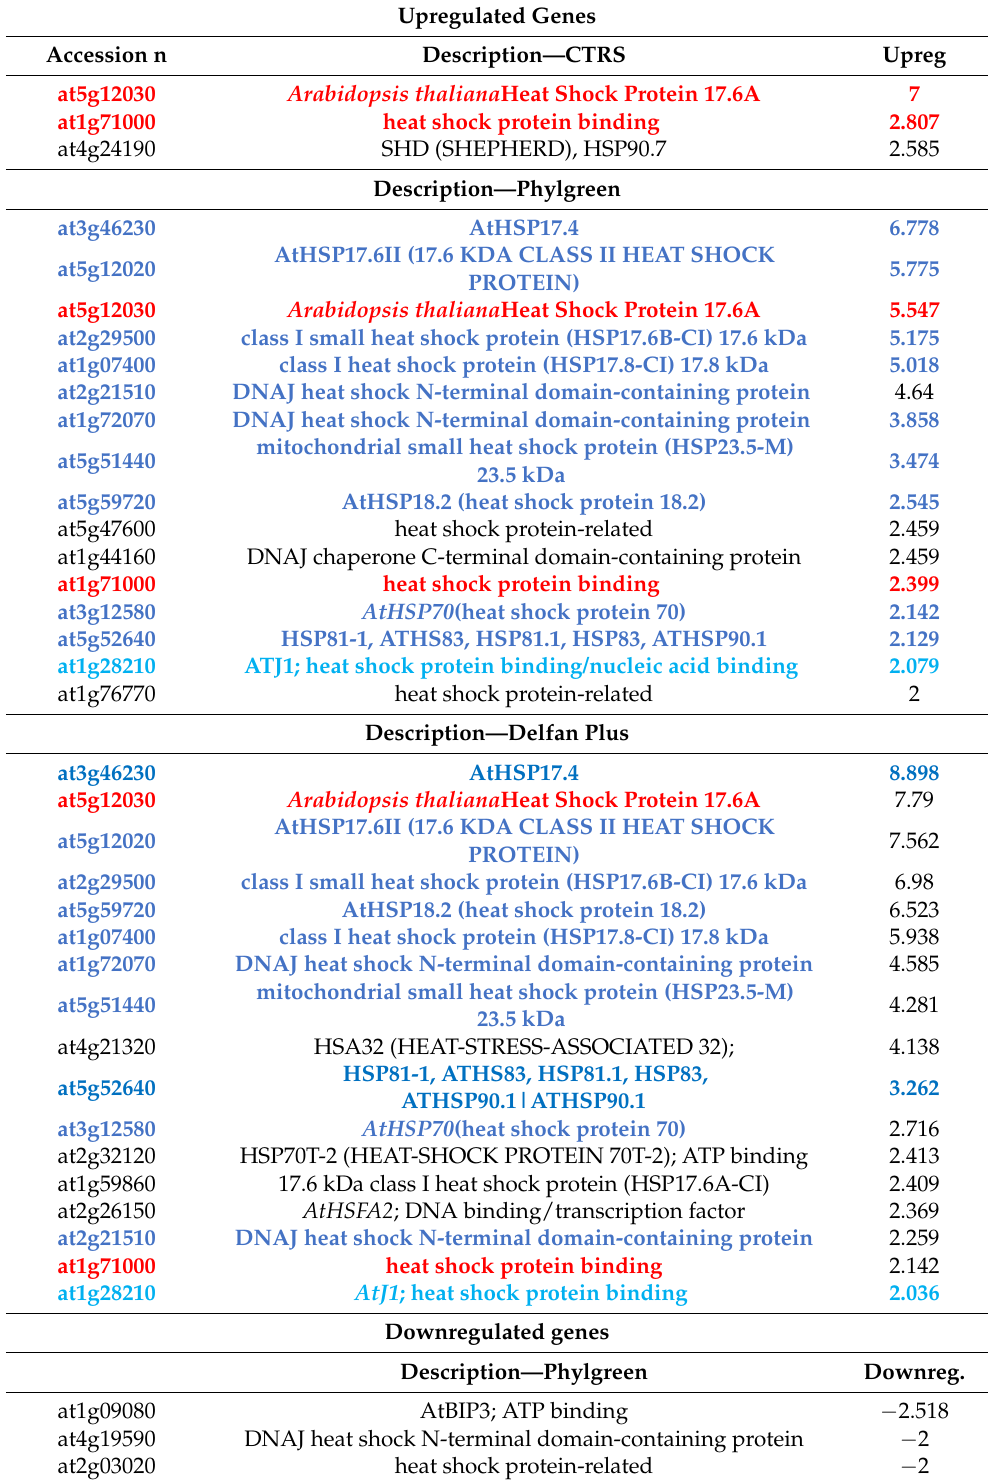
Table 1. Up- or downregulated (FC > 2) of differential expressed genes (DEGs) associated with heat stress in the CTRS, Phylgreen and Delfan Plus. Red bold color highlights DEGs common in all treatments, while blue bold color highlights DEGs common in Phylgreen, and Delfan